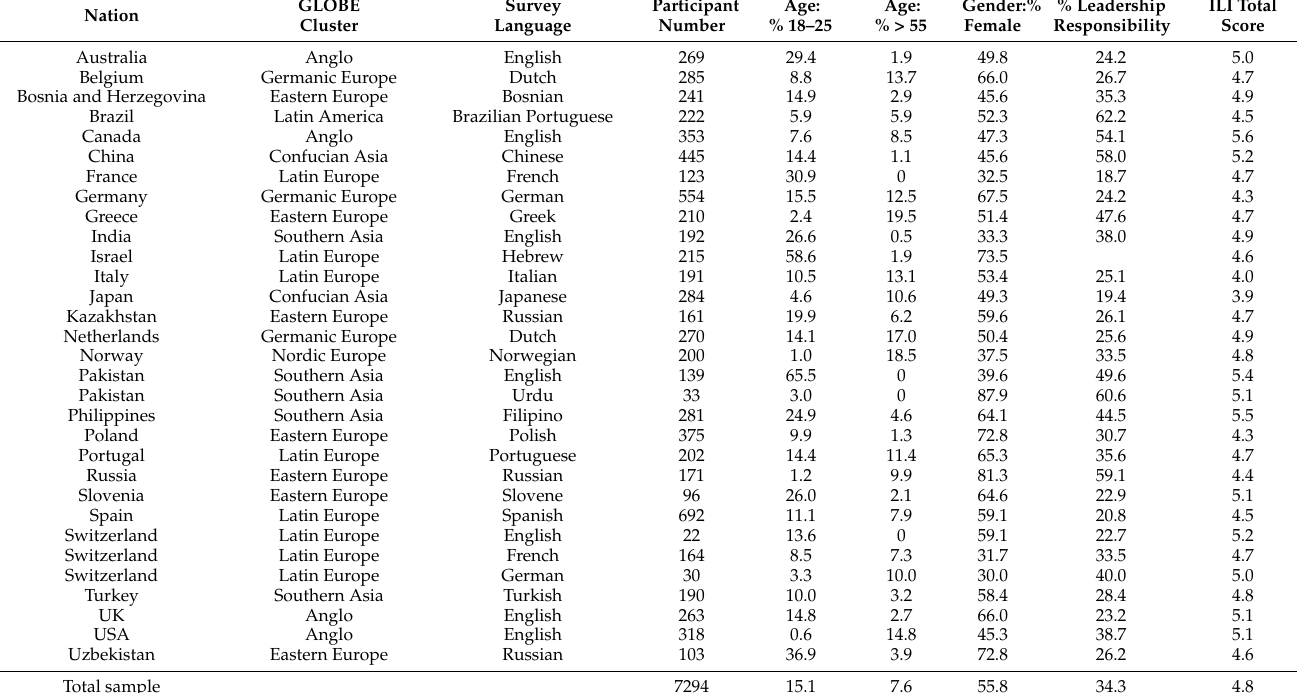
Table 1. Sample characteristics